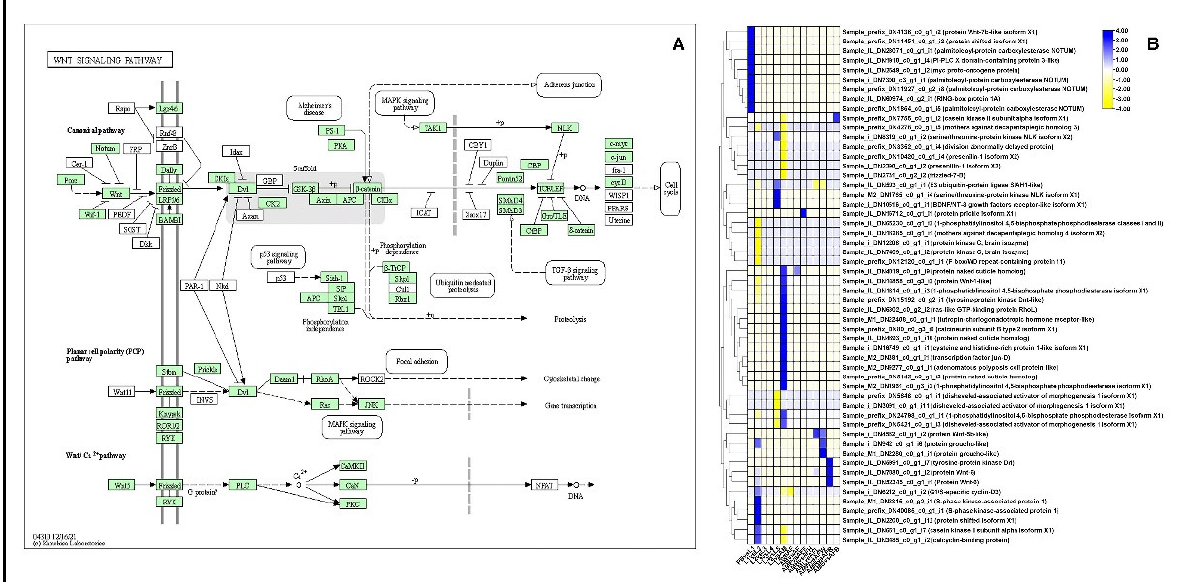
Figure 8. Identification of genes assigned to the Wnt signaling pathway in the P. bremeri transcriptome. KAAS was used to identify genes annotated by BLAST against the specific insect database and assigned to a KEGG pathway ( A ) Wnt signaling pathway components/genes. Colored boxes indicate the presence of the genes identified. A green colored box signifies the presence of an annotated gene that does not show a change in expression levels. ( B ) Heat map showing the log2-fold change of the FPKM values of the DEGs.